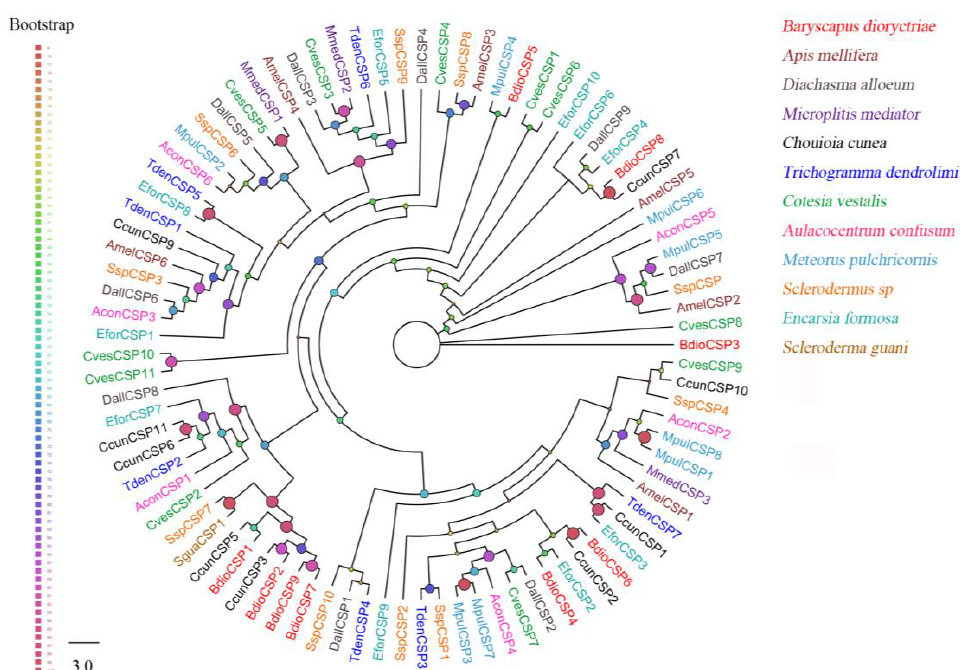
Figure 2. Phylogenetic tree of 90 chemosensory proteins (CSPs) from B. dioryctriae and 11 other Hymenoptera species. The protein sequences used in this phylogenetic analysis are listed in File S2. The size and color of the dots reflect their bootstrap values. The color scale is shown on the left, with larger dots indicating larger bootstrap values.